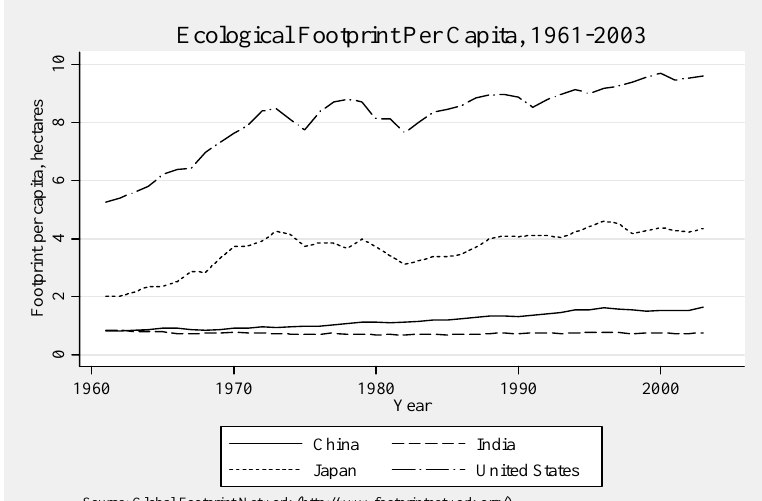
Ecological Footprint Per Capita, 1961-2003